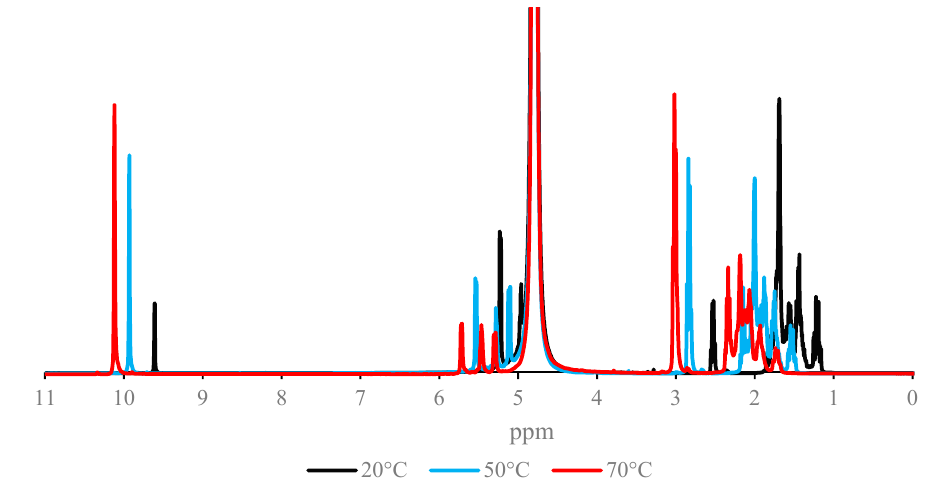
Figure 2. 1 H-NMR spectra of 12.5% glutaraldehyde in D 2 O at varying temperatures. Chemical shifts (parentheses show, in this order: the coupling type, coupling constant when not singlet, the integrated value, and the chemical assignment to the extent available / possible) in parts per million (ppm) for room temperature: 9.611 (singlet, 2H, CHO), 5.235 (doublet of doublets, 6 Hz / 2Hz, 8.31H, unsaturated), 4.972 (sextet, 2.8 Hz, 6H, unsaturated), 2.533 (quartet of doublets, 7.2 Hz / 1.2 Hz, 4.29H, aliphatic), 1.832 (multiplet, not determined (n.d.), 2.21H, aliphatic), 1.702 (multiplet, n.d., 27H aliphatic), 1.566 (multiplet, n.d., 12H, aliphatic), 1.445 (multiplet, n.d., 14H, aliphatic), 1.224